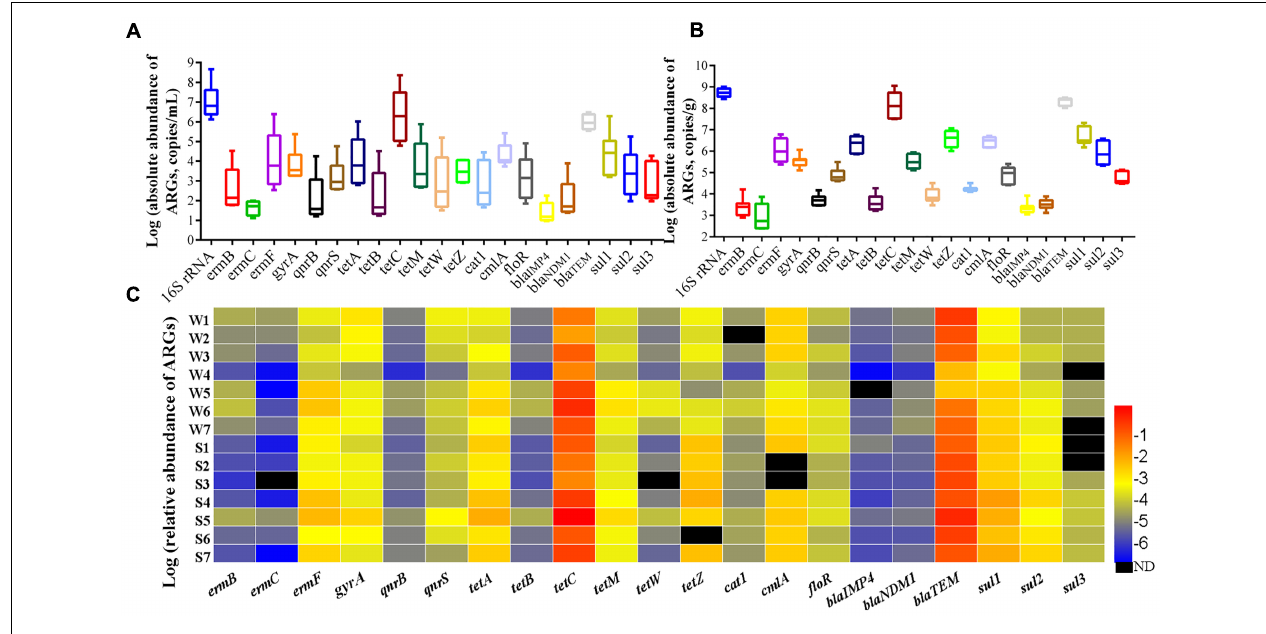
FIGURE 7 | Absolute abundance of ARGs in water (A) and sediment (B) samples, and relative abundance of ARGs (C)